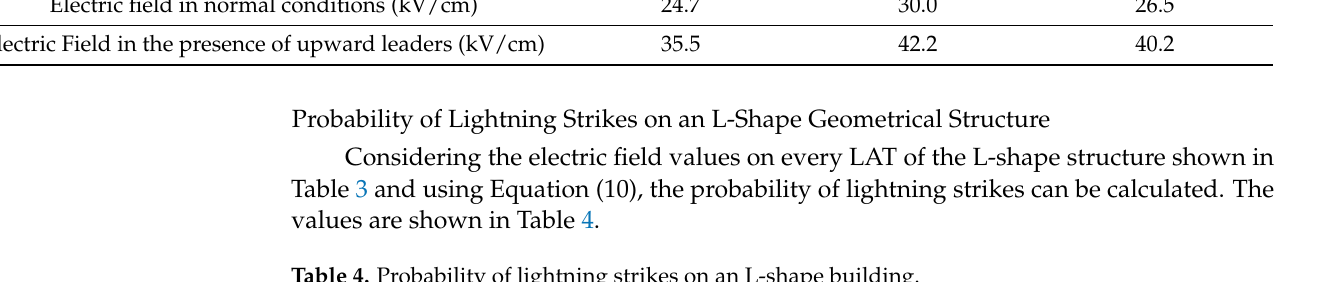
Table 4. Probability of lightning strikes on an L-shape